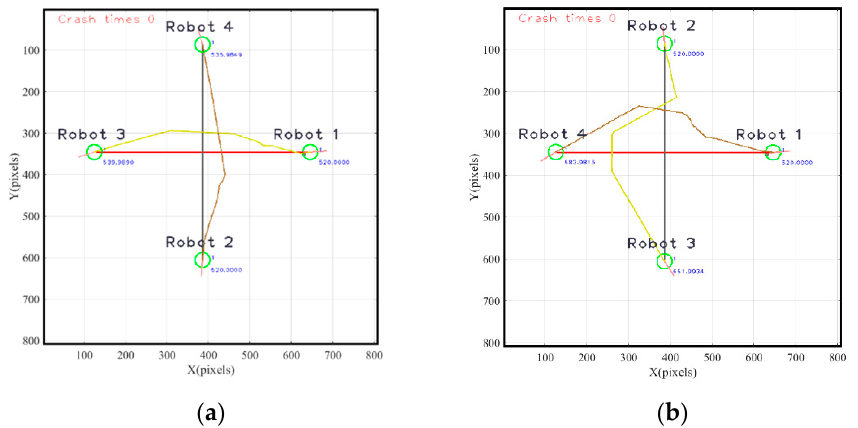
Figure 14. The results of four robots. ( a ) The best result of NSPP(1234) and ( b ) the worst result of NSPP(1342).